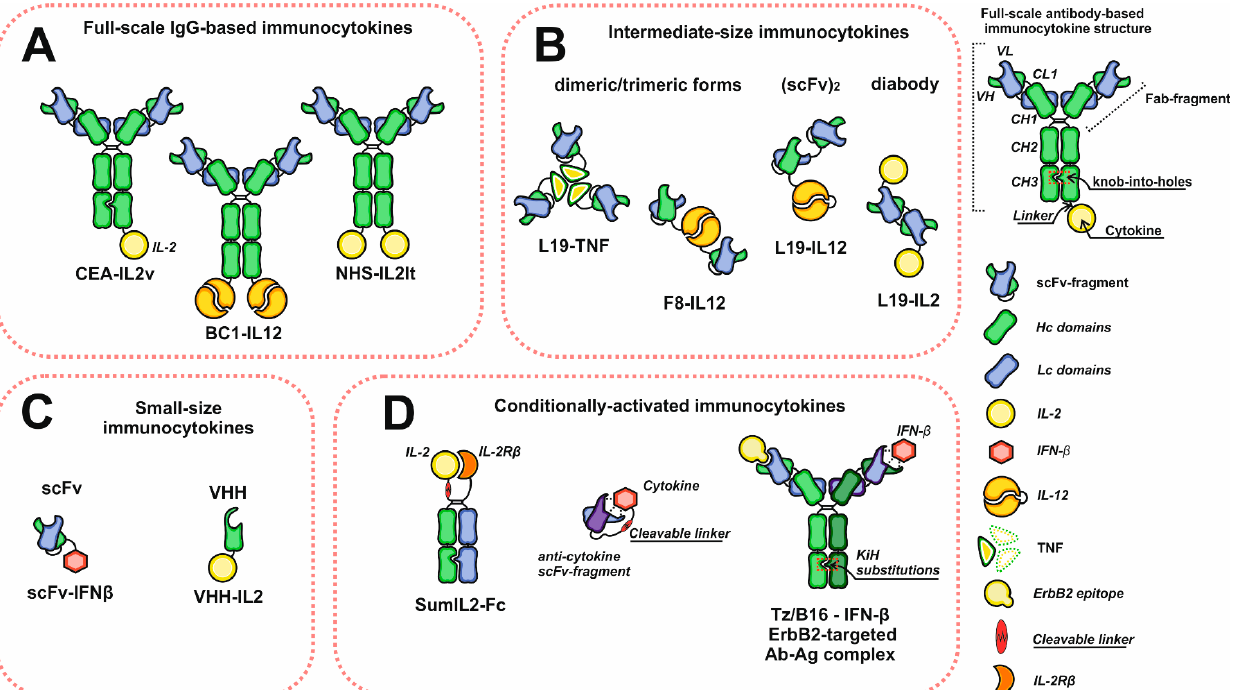
Figure 1. Schematic representation of the diversity of immunocytokine formats. ( A ) Immunocytokines based on full-scale IgG. ( B ) Intermediate-size immunocytokines. ( C ) Small-size immunocytokines based on antibody scFv or VHH fragments. ( D ) Conditionally activated immunocytokines. Abbreviations: VH and VL—heavy and light chain variable domains; CL—light chain constant domain; CH1, CH2, CH3—heavy chain constant domains; scFv—single chain variable fragment; VHH—single domain antibodies.